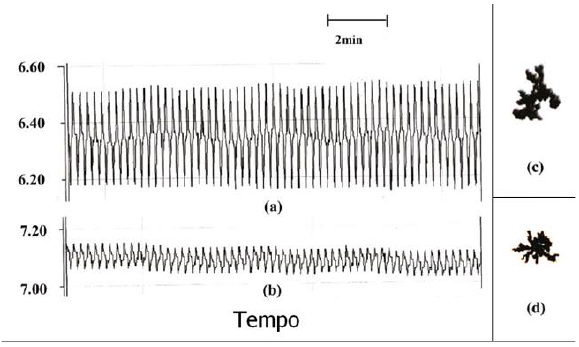
Fig. 3. The oscillatory behavior, observed during the electropolymerization of pyrrole in strongly acid media with (a) and without (b) the use of surfactants, (c) and (d) represent the surface modifications. Reproduced from [23] with the permission of Elsevier, the